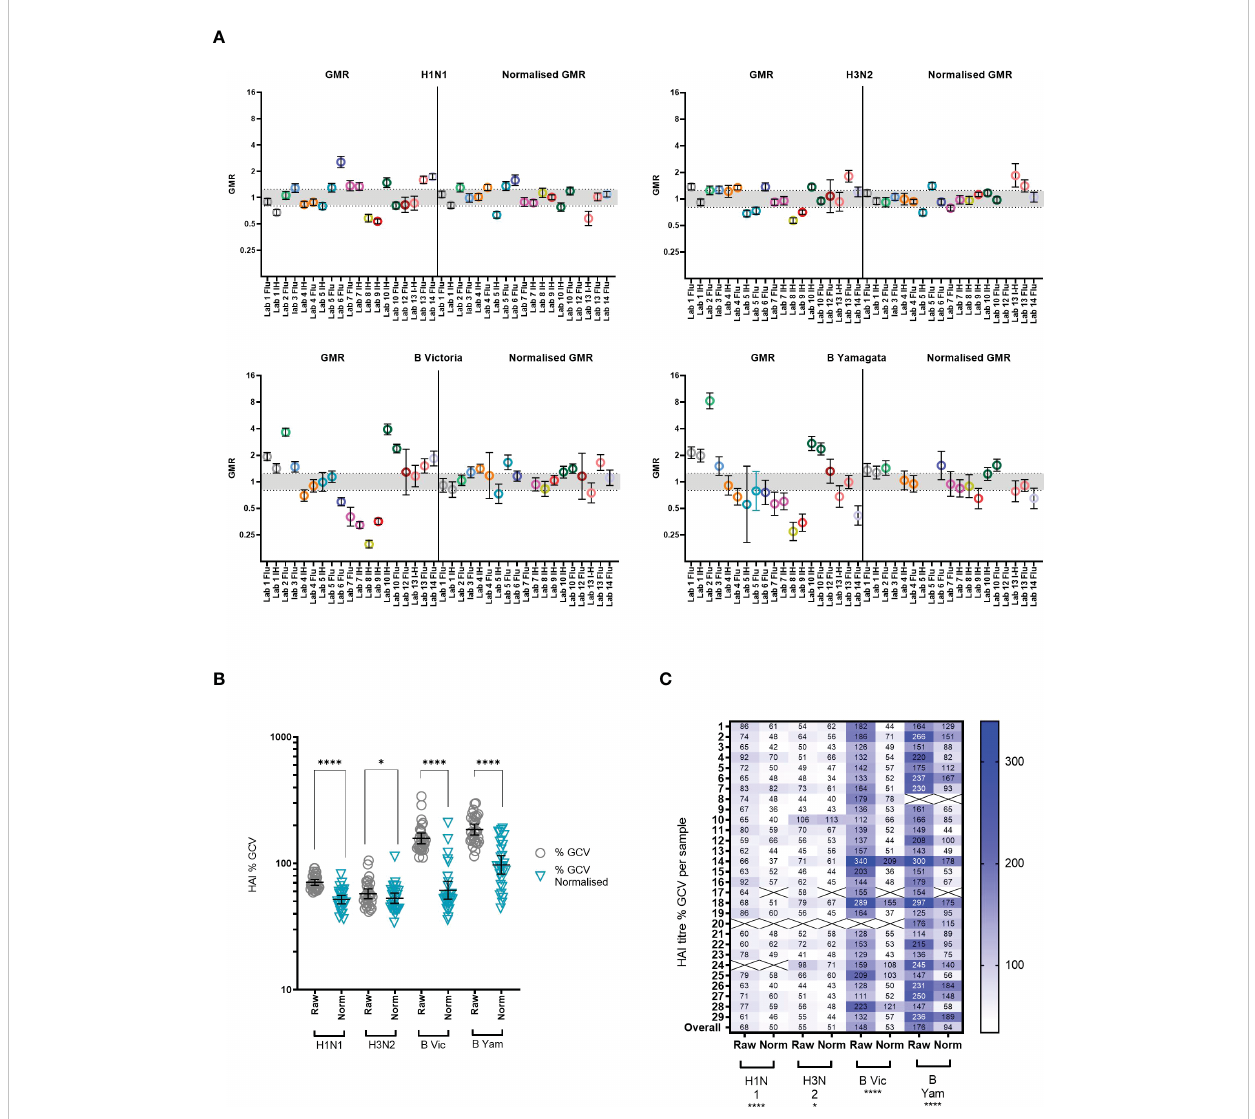
FIGURE 3 Impact of normalisation on inter-laboratory agreement in HAI testing. (A) GMR of HAI titres for each sample before and after normalisation using Pool 1 (sample 17) as a study standard. Negative samples (HAI GMT <10) were excluded from analysis. Where a laboratory did not return a valid titre for the study standard in each reported run, that laboratory was excluded from analysis (Lab no.12 (H1N1), Lab no.12 (H3N2), Lab no.7 (B Victoria) and Labs no.3 and 5 (B Yamagata)) Geometric mean (circles) and 95% CI (black lines) are shown. The indicative interval of 0.8-1.25 is shaded in grey. Each laboratory has a unique number and colour in all graphical representation of data. (B, C) . %GCV of sample HAI titres before and after normalisation using Pool 1 (sample 17) as a study standard. Samples with a GMT <10 were excluded from analysis (shown as Xs in 5C). The Wilcoxon matched pairs test was used for statistical analysis (H1N1, B Vic and B Yam P<0.0001 ****, H3N2 P=0.0146 *). Data are shown for each virus tested: H1N1 A/Michigan/45/15-like, H3N2 A/HongKong/4801/14-like, B Victoria B/Brisbane/60/08-like and B Yamagata